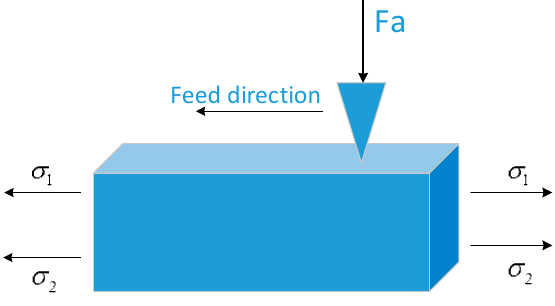
Figure 2. Stress load during single abrasive grinding.